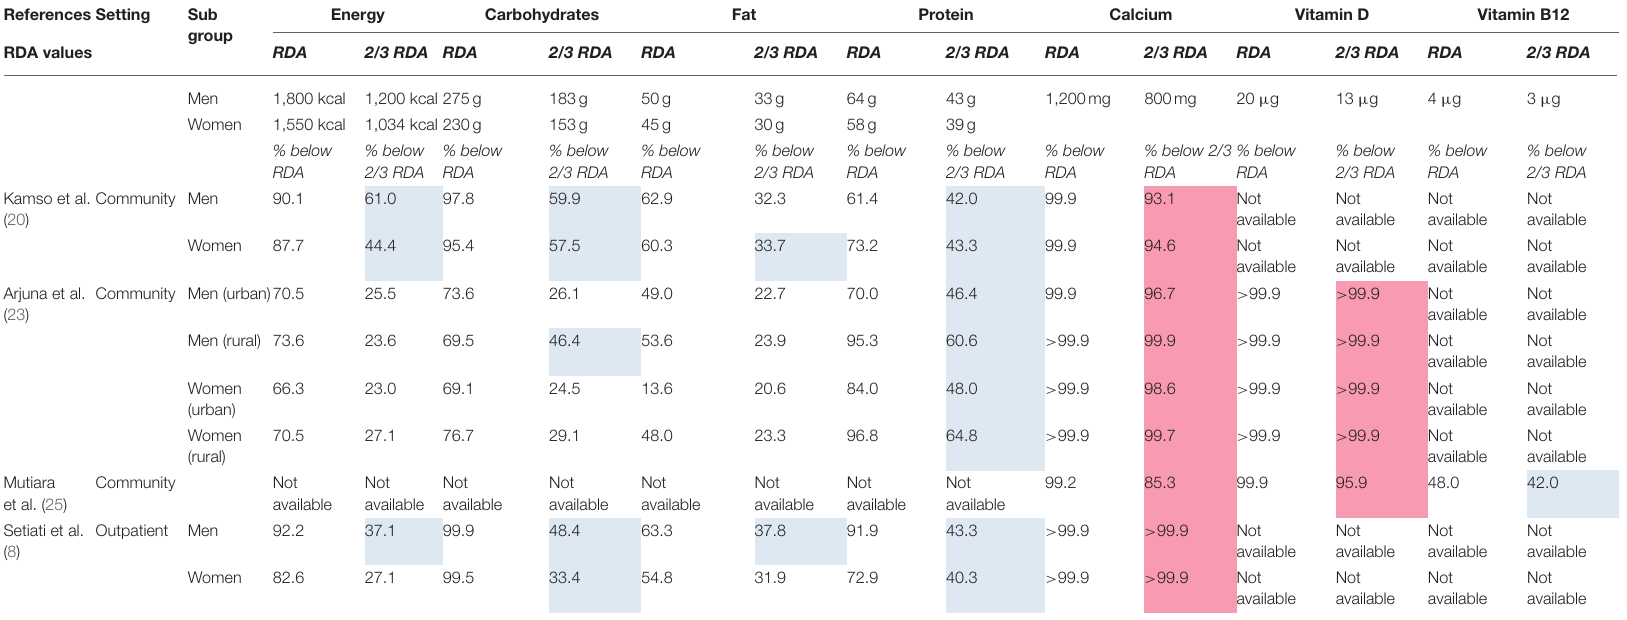
TABLE 6 | Prevalence of energy, macronutrients, and a selection of Micronutrients Intakes below RDA and Estimated EAR. References Setting Sub Energy Carbohydrates Fat Protein Calcium Vitamin D Vitamin group